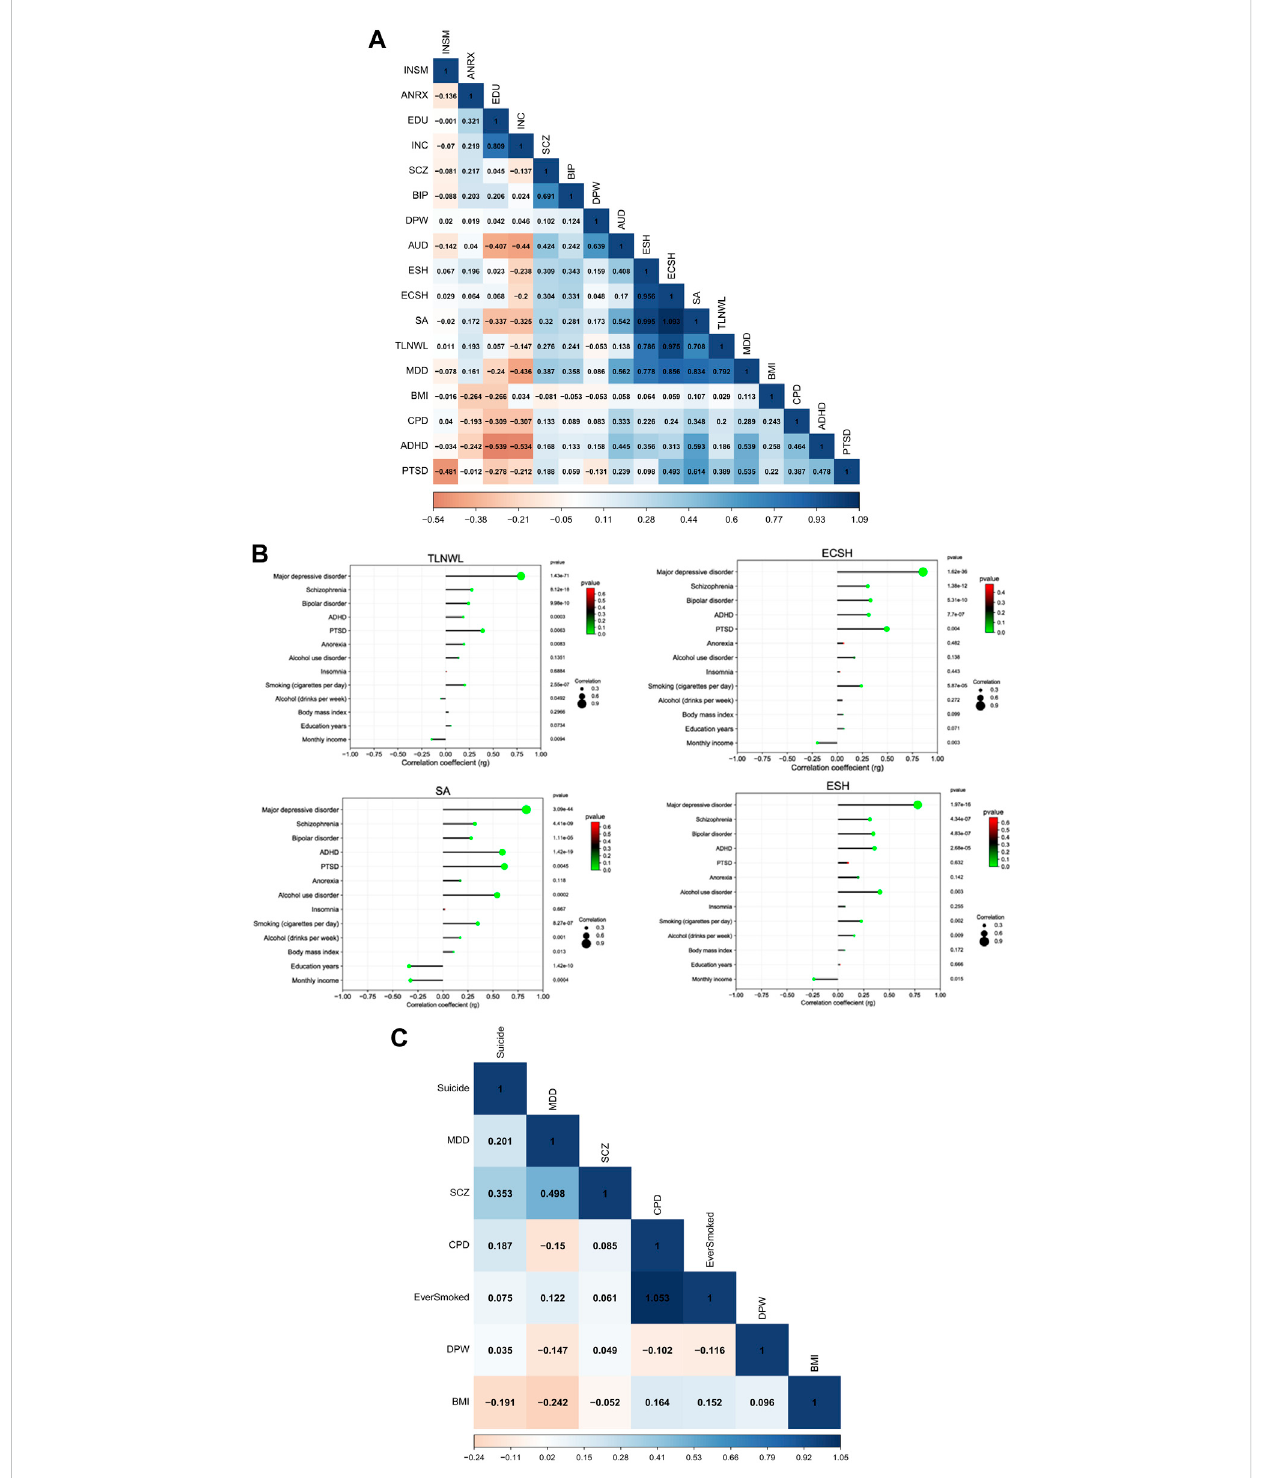
FIGURE 1 PairwiseLDSC-estimatedgeneticcorrelationbetweenSBandpsychiatricdisorders,behaviouralandSEStraits (A) Heatmapshowingthecorrelationbetween 17 traits among European populations, (B) a correlation dot plot showing the association between four suicidal behaviour traits (TLNWL, ECSH, SA and ESH)and psychiatric disorders, behavioural and socioeconomic (SES)-related traits among European populations. The size of the dot represents the strength of the correlation,and (C) aheatmapofseventraitsincludingcompletedsuicideamongEastAsianpopulations.Thestrengthofthegeneticcorrelationispresentedas aheatscaleonthe x -axiswithbluecolourindicatingpositiveandredcolourrepresentingnegativecorrelations.Lightcoloursrepresentlowercorrelationestimates, whereas darker colours indicate stronger correlations. Abbreviations: (SB traits) TLNWL = Thought life is not worth living, ECSH = Ever contemplated Self-harm, ESH=Everself-harmed,SA=Suicideattempt;(Psychiatric,behaviouralandsocioeconomic-relatedtraits)MDD=majordepressiondisorder,SCZ=schizophrenia, BIP=bipolardisorder,AUD=alcoholusedisorder,ADHD=attentionde fi cithyperactivitydisorder,PTSD=post-traumaticstressdisorder,ANRX=anorexianervosa, INSM = insomnia, BMI = body mass index, DPW = drinks per week, CPD = cigarettes per day, INC = monthly income and EDU = education in